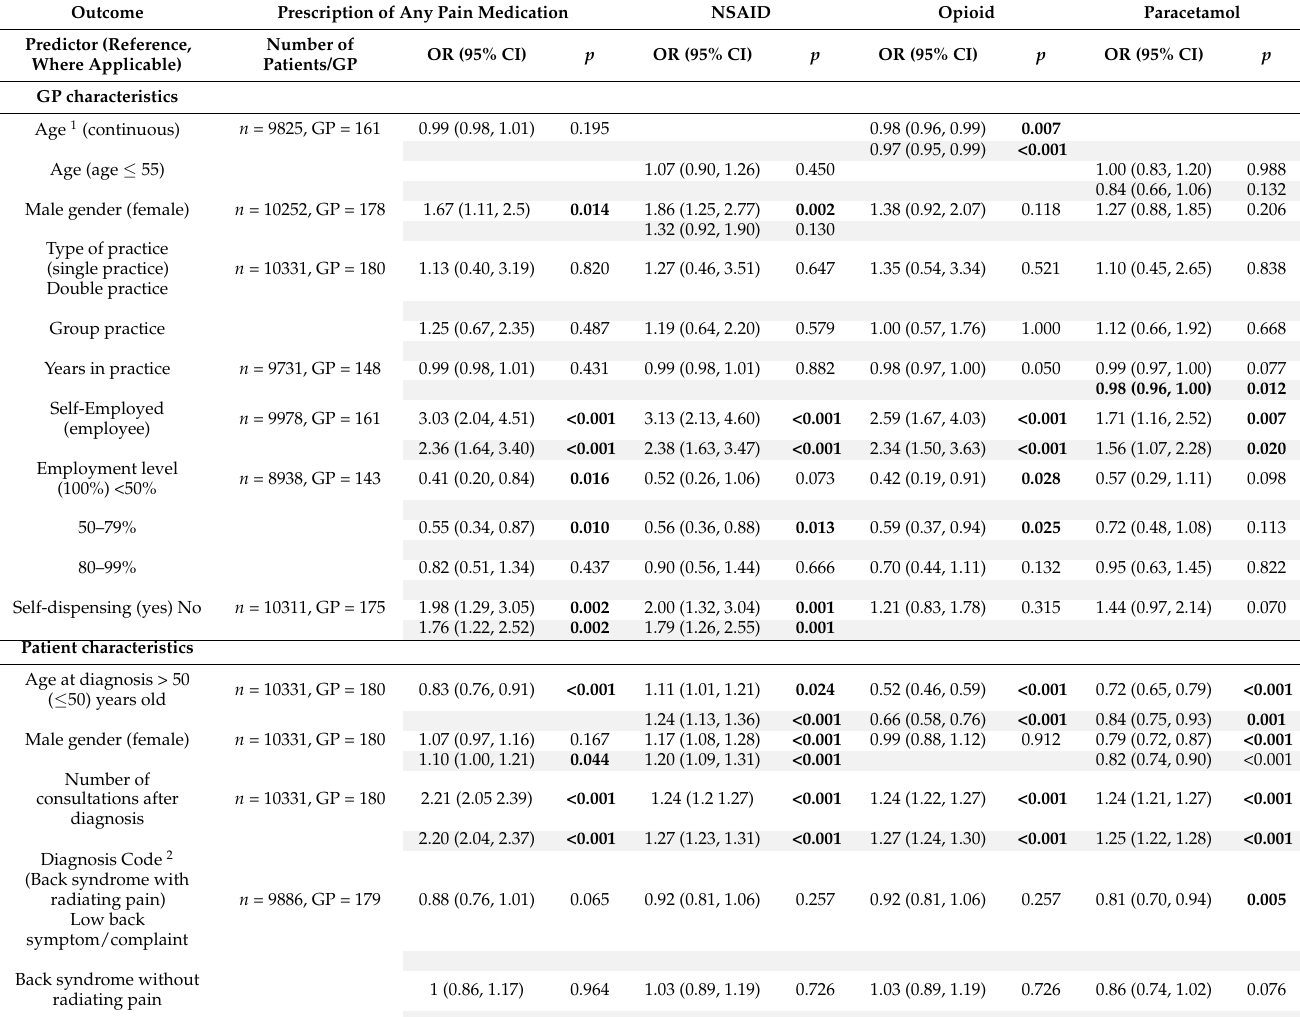
Table 3. Association between patient and GP characteristics (predictors) and pain medication prescription (binary outcome): mixed-effects logistic regression analysis, accounting for correlation within